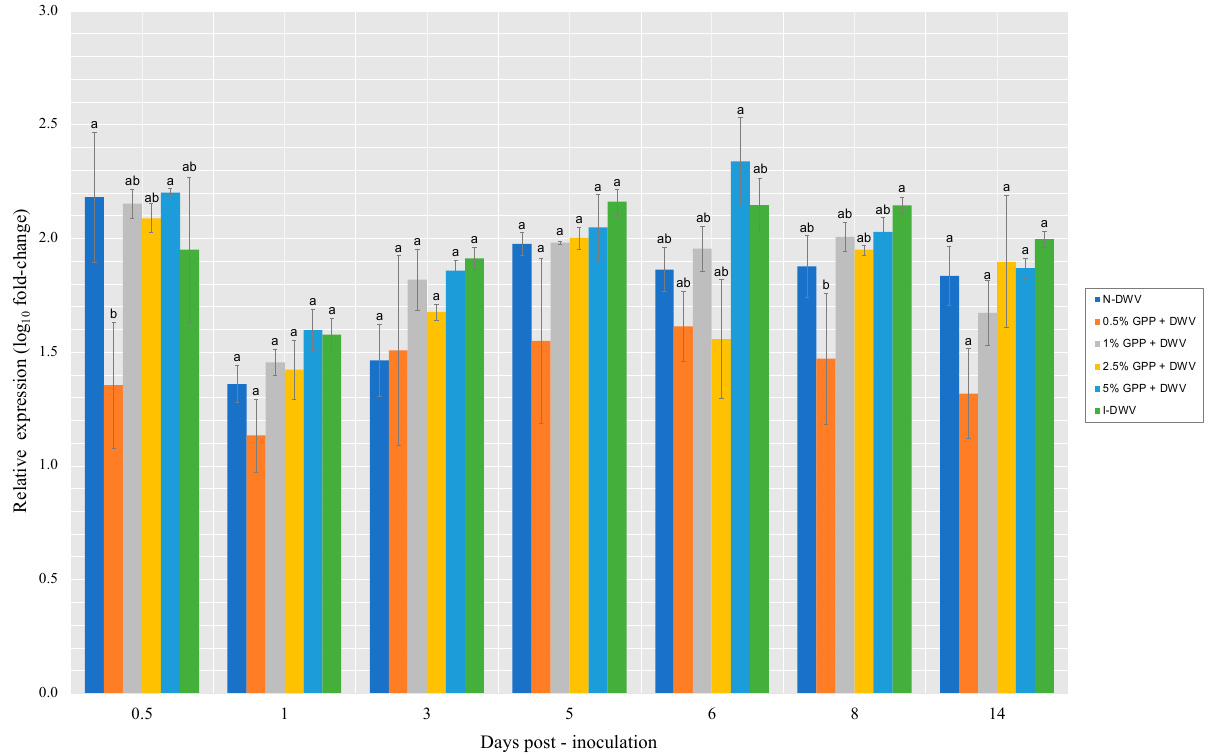
Figure 5. Expression level of Vago gene in worker honeybees per collection throughout the assay. Grape pomace powder (GPP) concentrations (0.5, 1, 2.5 and 5%), inoculated control (I-DWV) and non-inoculated control (N-DWV) are shown in different colors. Different letters indicate significant differences according to Tukey’s test ( p < 0.005).